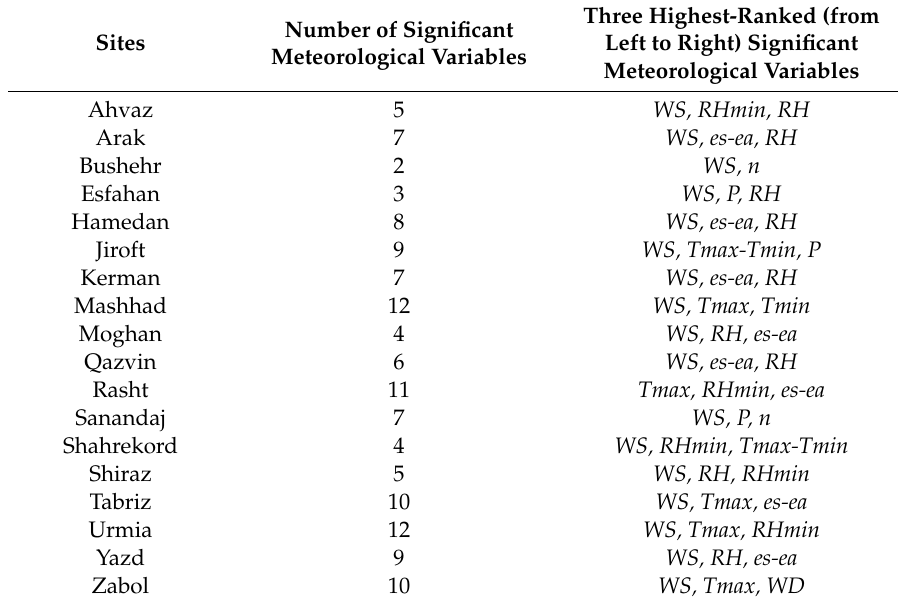
Table 5. The total number of meteorological variables in each site with significant correlations with ET o , and the three meteorological variables with the highest significant correlation with ET o . Three Highest-Ranked (from Number of Significant Left to Right) Significant Sites Meteorological Variables Meteorological Variables Ahvaz 5 WS, RHmin, RH Arak 7 WS, es-ea,